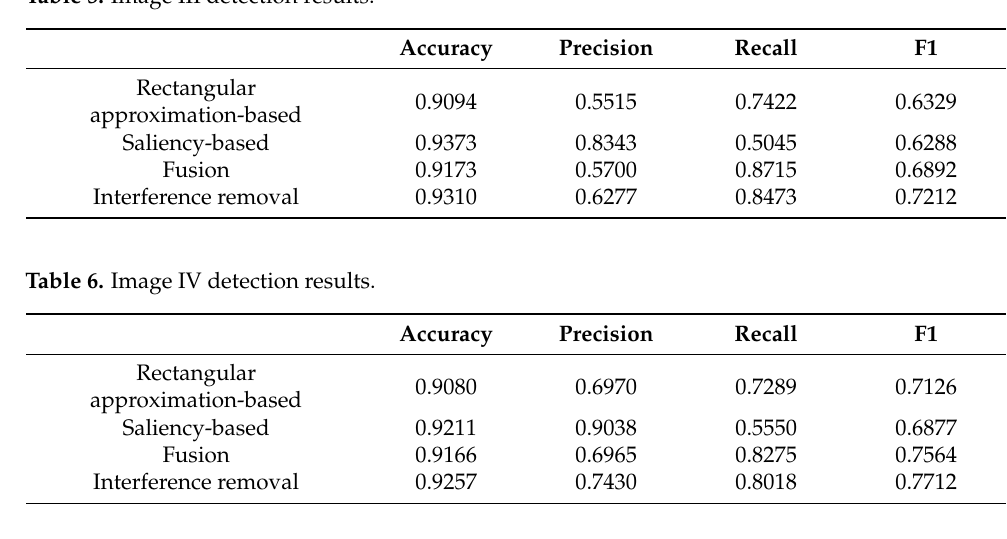
Table 5. Image III detection results.